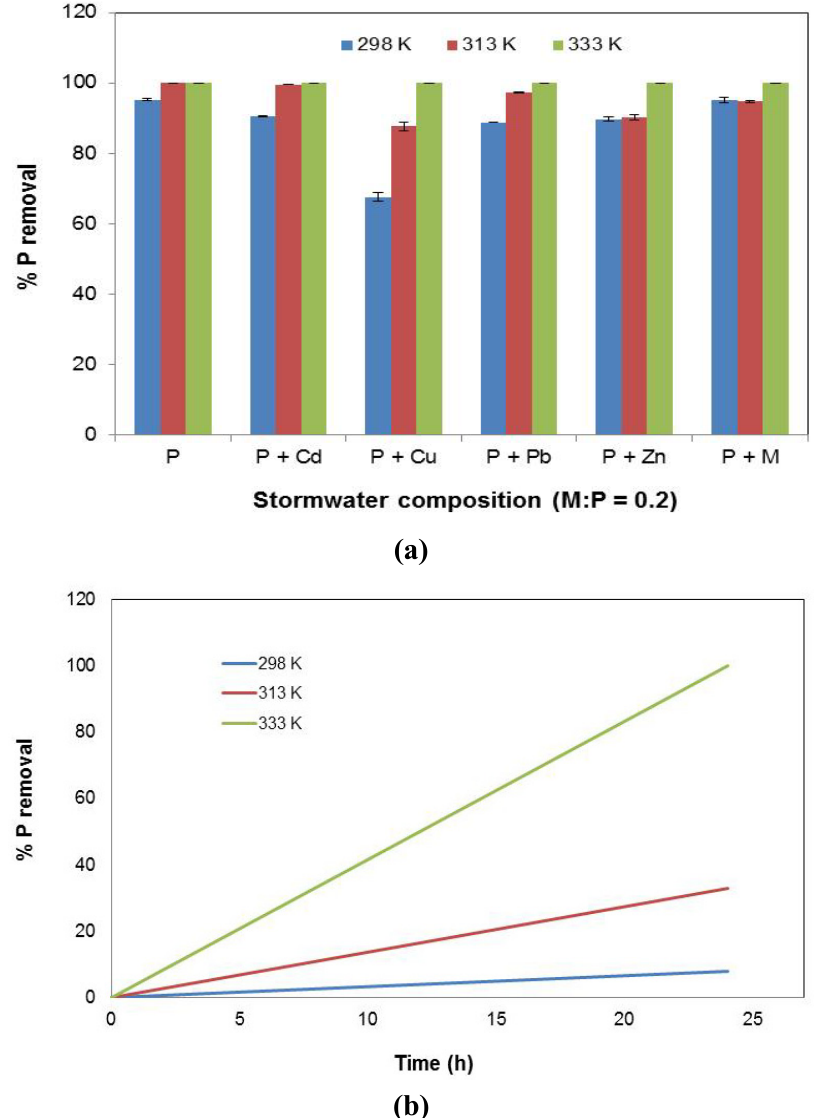
Figure 9. The effect of temperature on % P removal. ( a ) P conversion (%); ( b ) P removal rate from stormwater type P over 24 h (% P